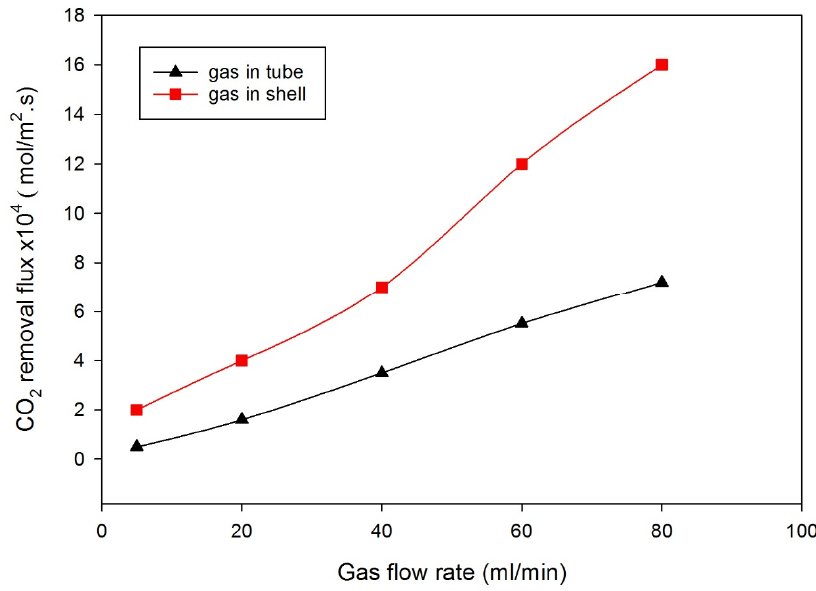
Figure 3. Comparison between the oscillatory gas flows in the shell and tube sides at operating conditions (temperature of 25 °C, atmosphere pressure, liquid flow rate of 10 mL/min).